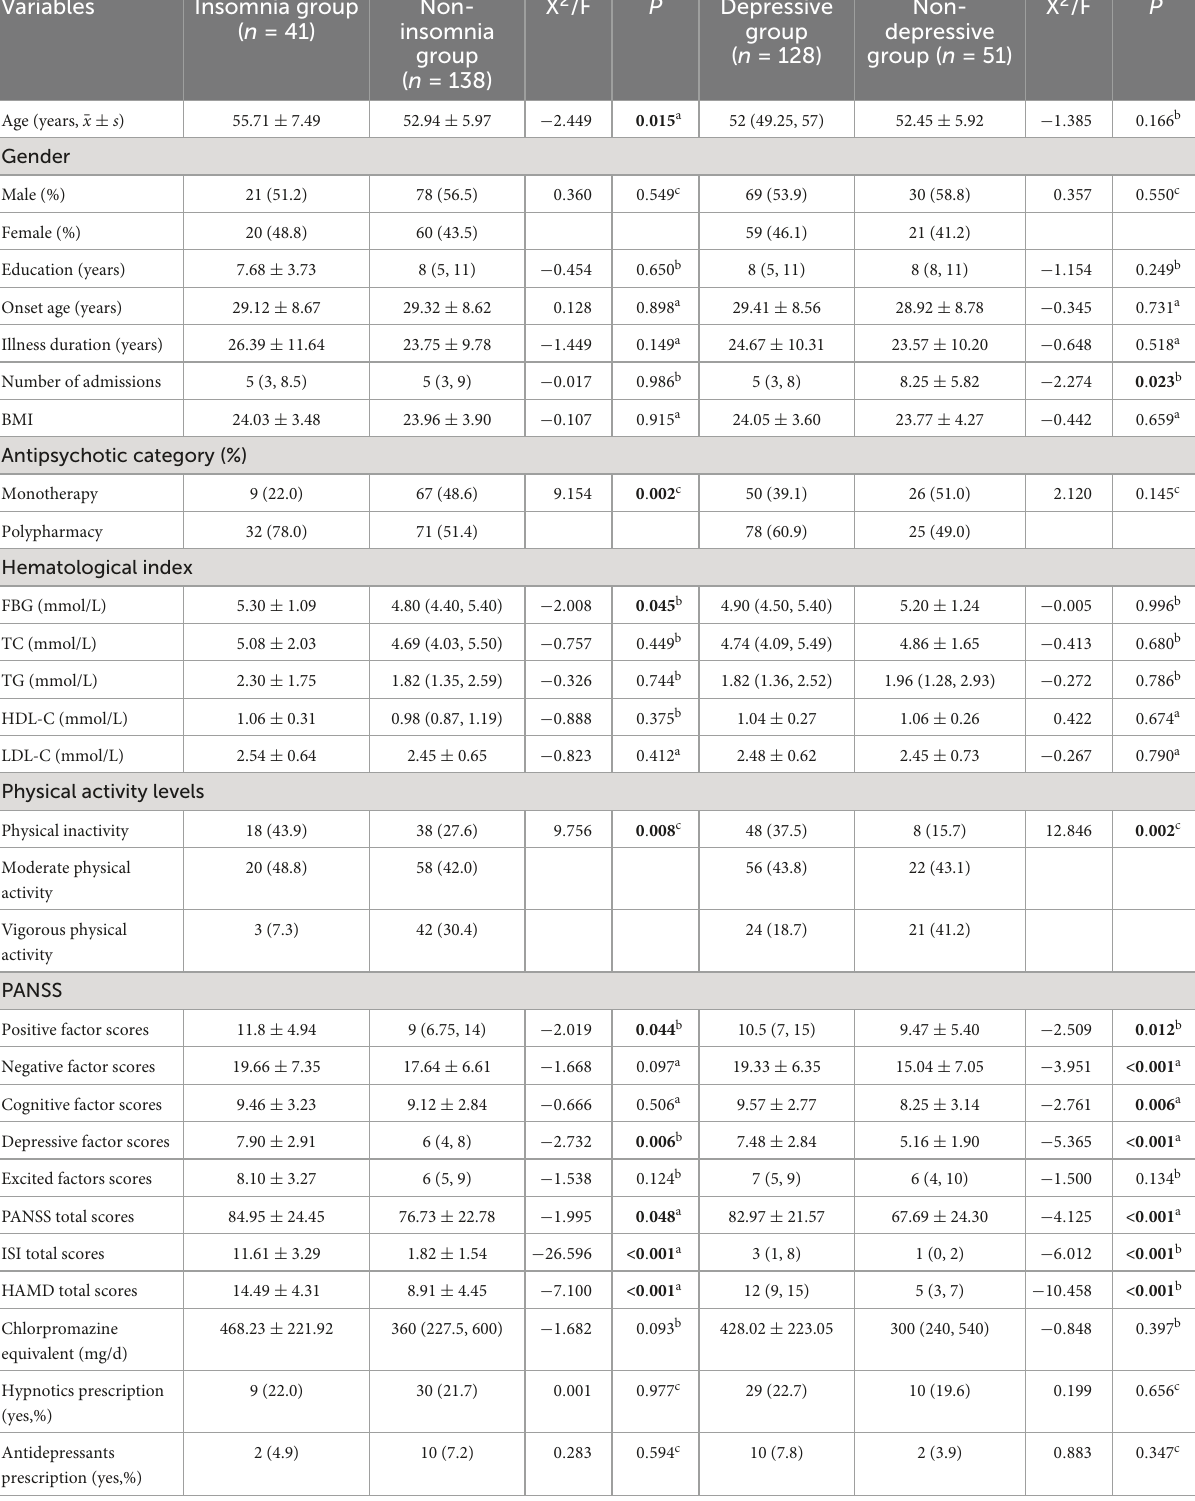
TABLE 1 Comparison of clinical and biological indicators between insomnia group and non-insomnia group, depressive group, and non-depressive group.